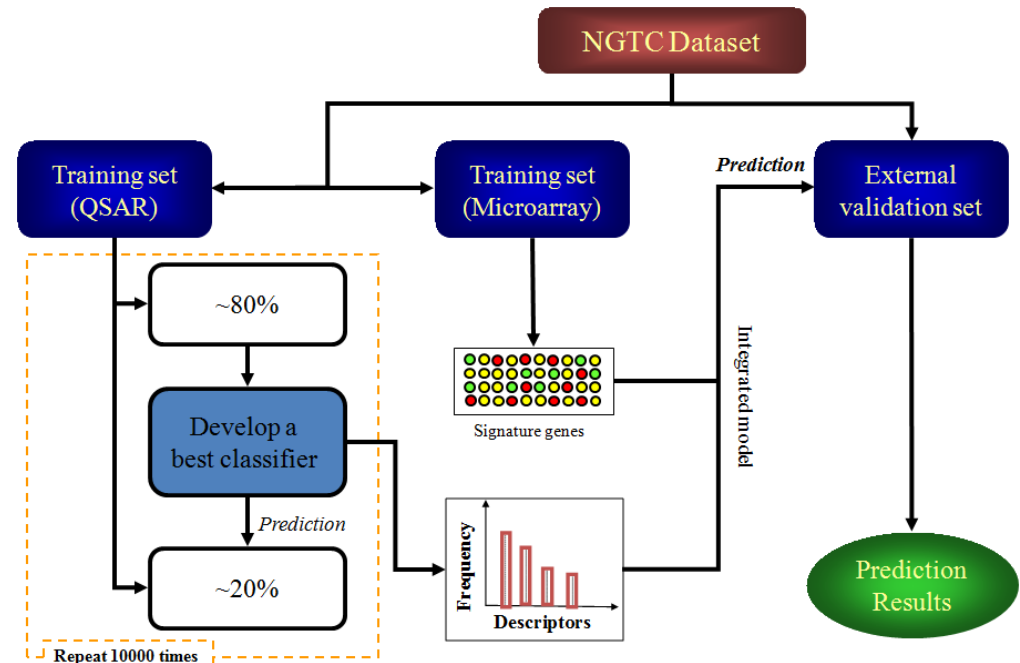
Figure 5. Work flow for developing the integrated